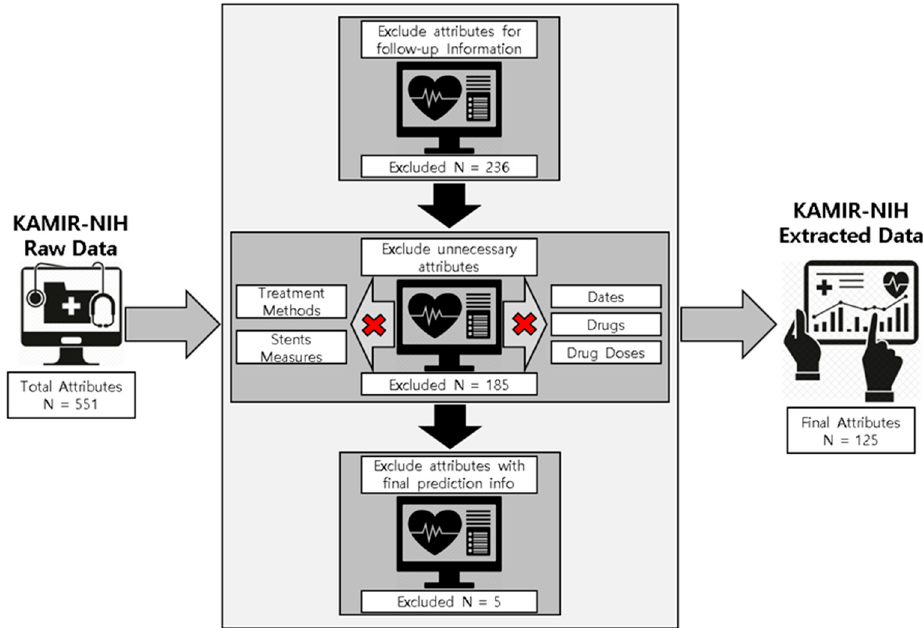
Figure 1. Experimental data extraction from the original KAMIR-NIH dataset.